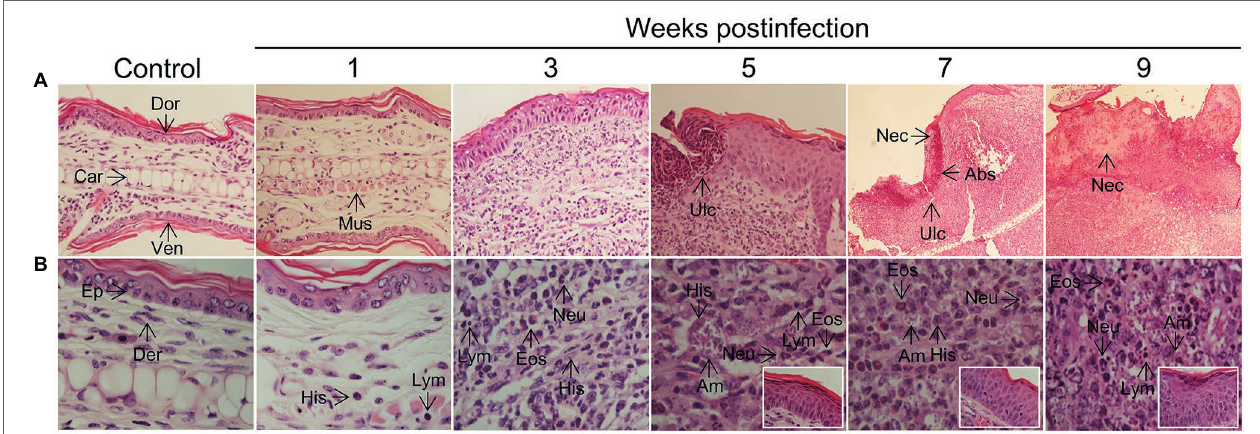
FIGURE 5 | Histopathology of L(V)p -infected BALB/c mice ears. Representative photographs of hematoxylin/eosin-stained ear sections from the infected mice at the indicated week postinfection are shown. A photograph of a section from a normal non-infected mouse was also included (Control) for comparison. Magnifications are 40X for control and 1–5 weeks postinfection, and 10X for 7 and 9 weeks postinfection in the upper panel (A) . In the lower panel, a 100X magnification was used for all photographs (B) , to document the appearance of the dermis. Insets in the lower panel show the appearance of the